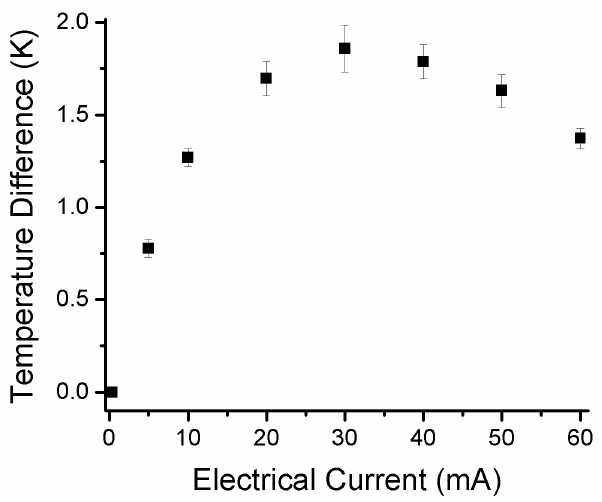
Figure 6. The variation of electrical currents as a function of temperatures at three applied voltage values (V R = − 0.8 V, − 0.9 V, and − 1.0 V) for the platinum resistor temperature sensor in the TE device, where the dots are the experimental data and the linear current-temperature functions were derived from the regression analysis of the experimental data.